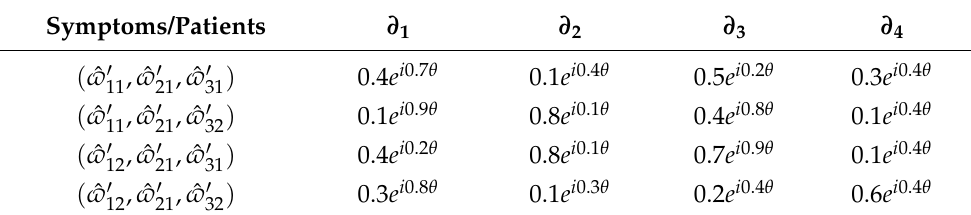
under C FH S mapping F